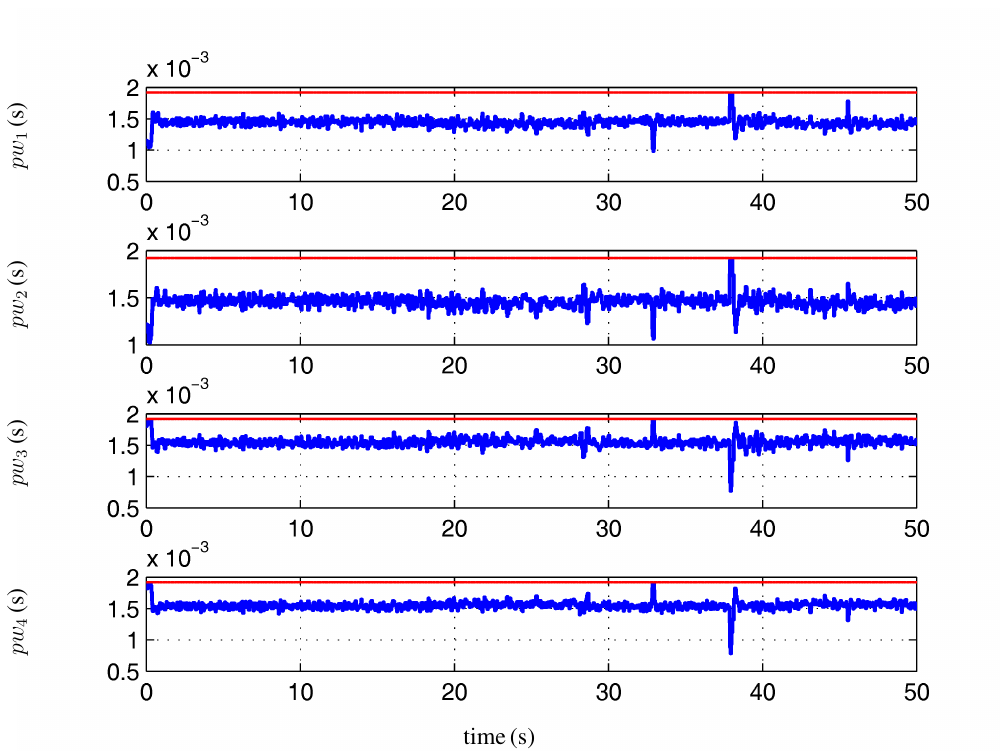
Figure 11. Control law of Corollary 1: the pulse width of the four motors’ control signals. The red dashed lines define the bounds of the pulse